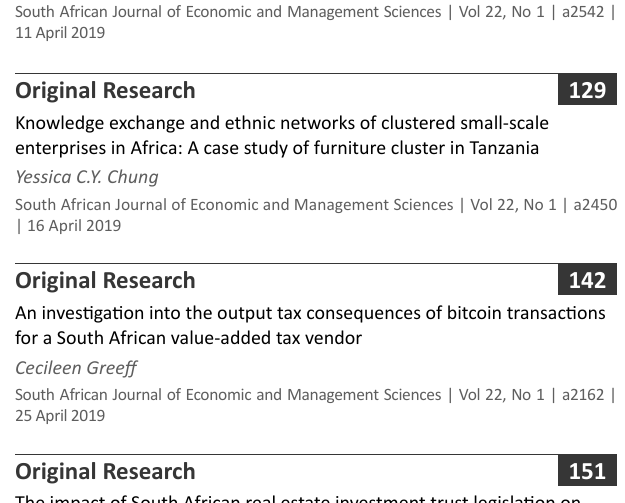
A test taker’s gamble: The effect of average grade to date on guessing behaviour in a multiple choice test with a negative marking rule